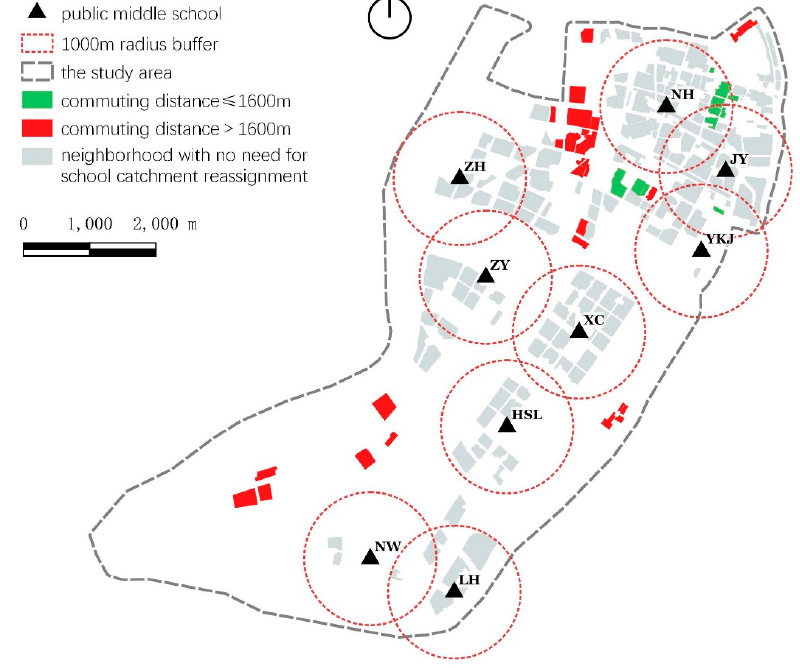
Figure 6. Neighborhoods classification in scenario analysis. (Neighborhoods colored in red represent commuting distances that were still longer than 1600 m after adjustment.).